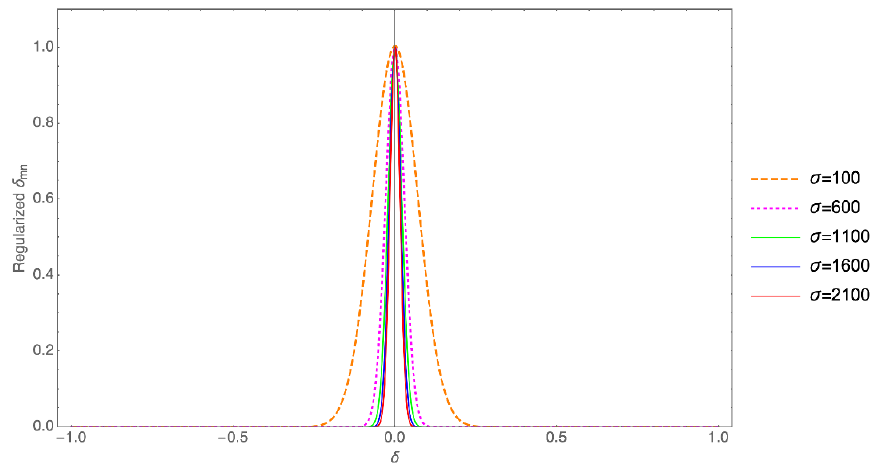
Figure 6 . The function in (D.1) evaluated for various values of (cid:27)